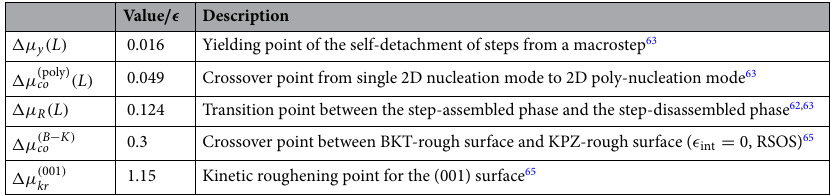
p 3 √ 2 / 8 0.530 . L 400 √ 2 a ( a ¯ = ≈ =